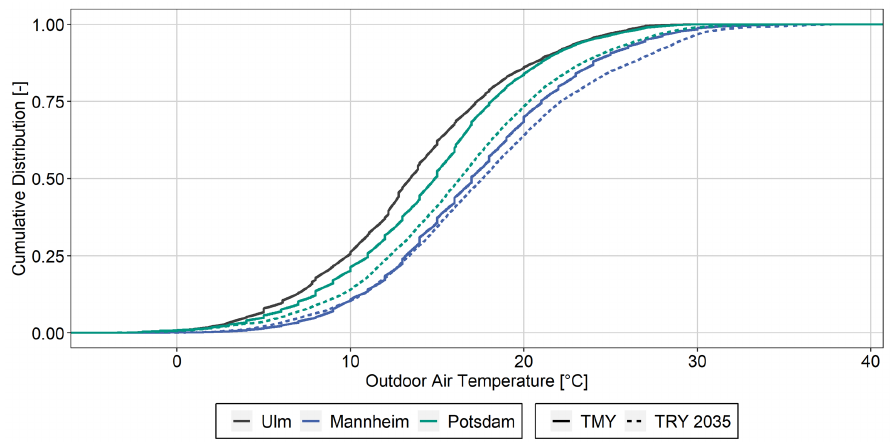
Figure 6. Cumulative outdoor air temperature distribution for the selected locations and climate